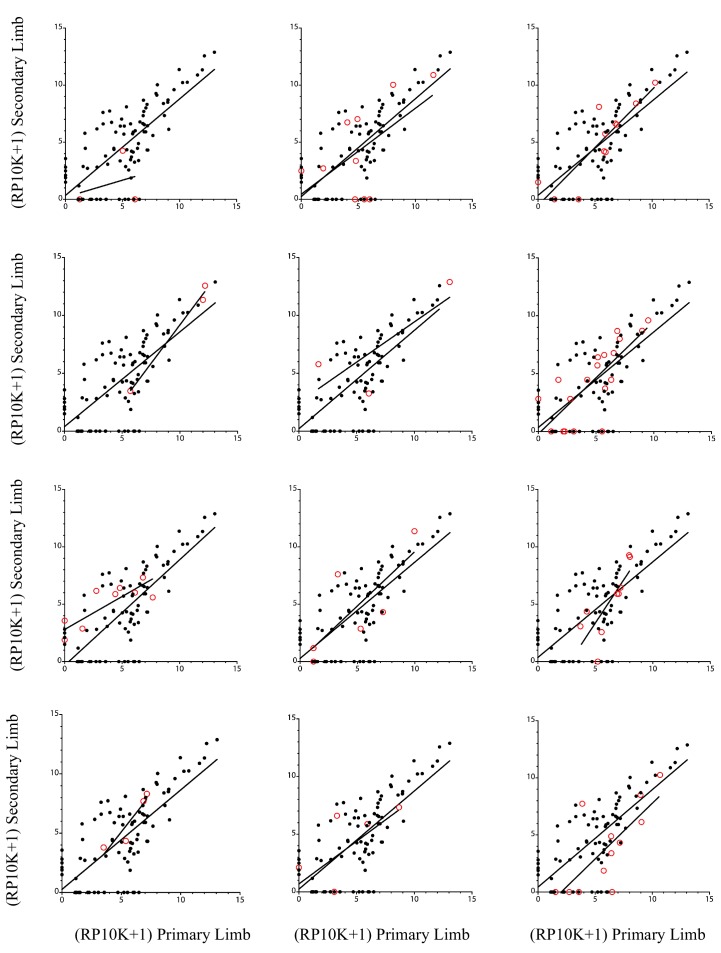
Comparison of all alleles generated in the controls (methyltransferase and tyrosinase) in the original and regenerated haploid limbs of 12 animals shown individually and compared to the entire remaining set of control alleles.In each graph, the open red circles depicts the log scores of the RP10K of every allele in the original limb compared to that of the same allele in the regenerated limb of an individual animal, while the black circles depict those of the alleles for all other control animals. The best-fit line for the linear regression of the alleles of each individual animal and that of those of all other control animals are depicted. There are no significant differences between the slopes of any best-fit lines with those of the remaining controls (from top-left to bottom-right, p=0.408, 0.699, 0.490, 0.273, 0.614, 0.534, 0.597, 0.767, 0.203, 0.211, 0.737, 0.652).